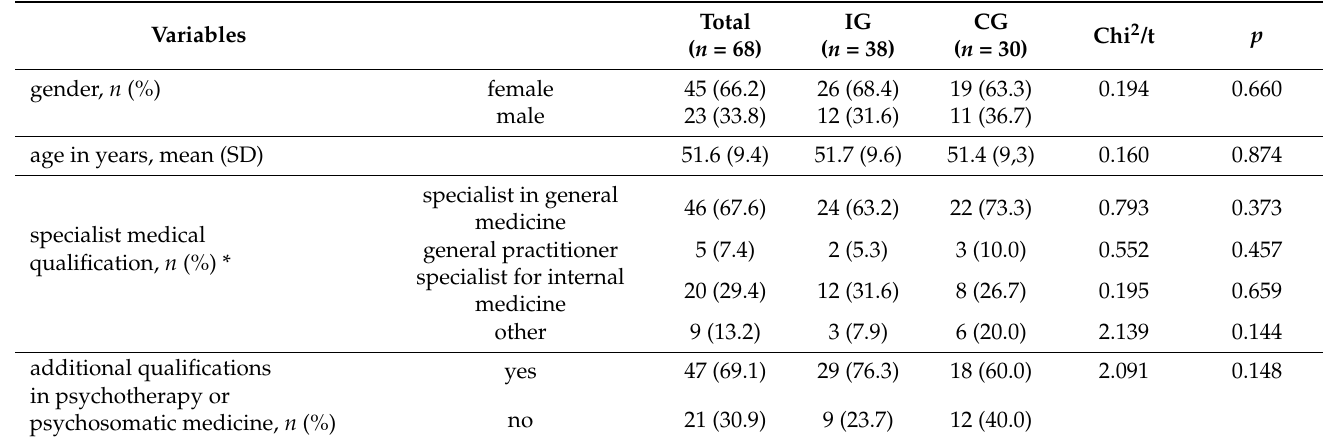
Table 1. Socio-demographic and vocational characteristics.